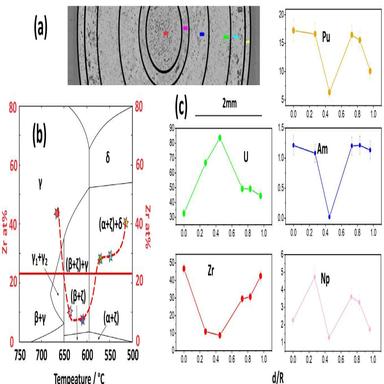
An overview of the microstructure reconstructed and sites for TEM sample extraction highlighted by different color (a); Zr concentration at these different sites overlayed on a pseudo-binary phase diagram from Ref. ; (c) the element redistribution for U, Zr, Pu, Am, and Np as revealed by six TEM samples.